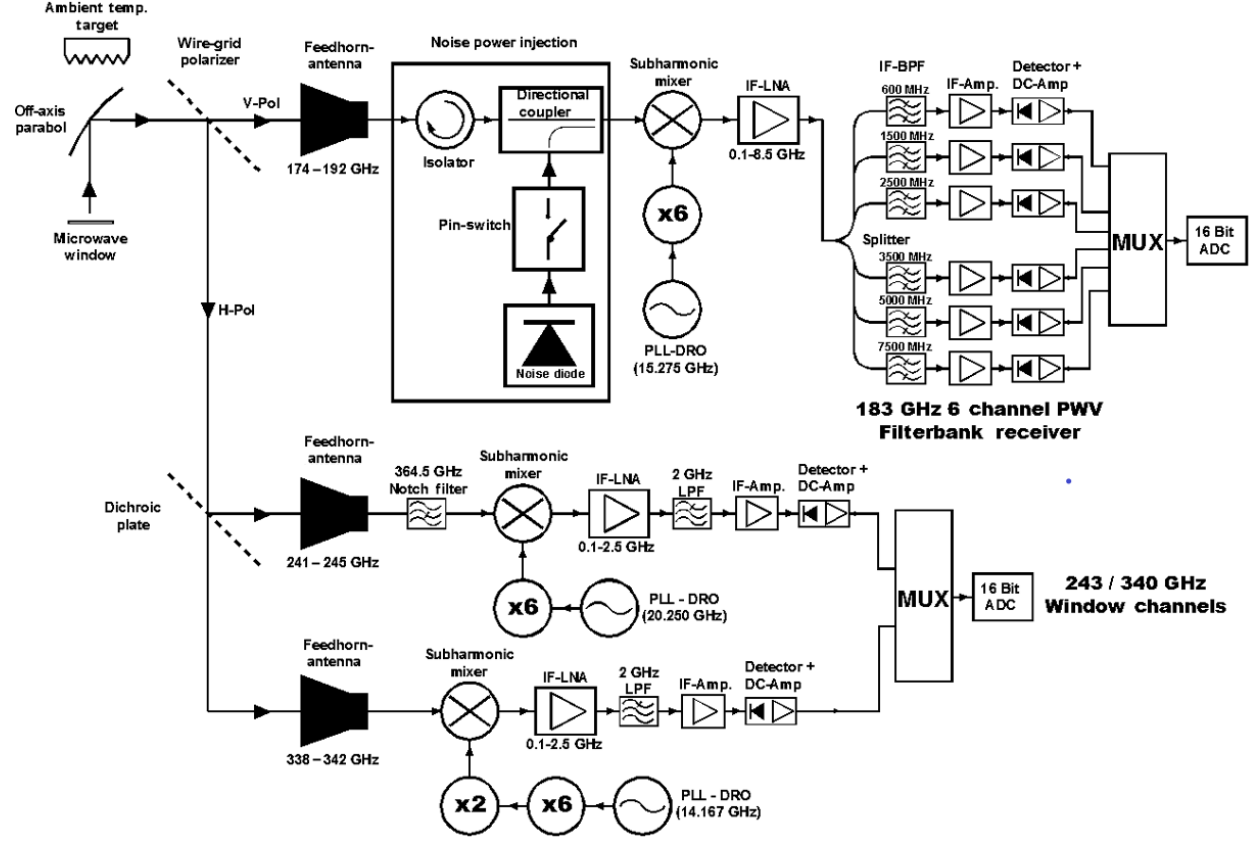
Figure 2. Block diagram of